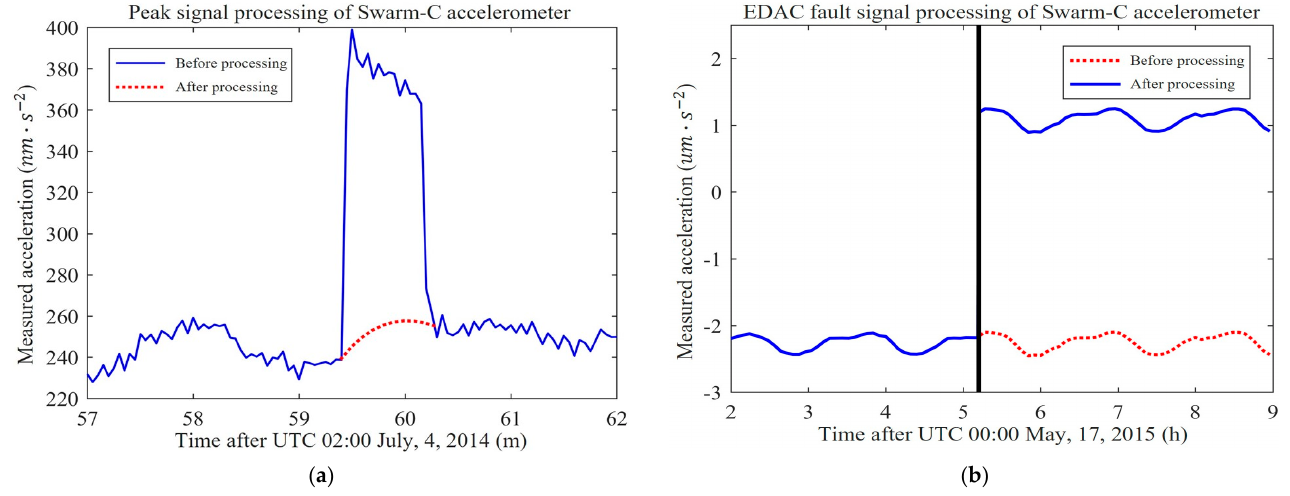
Figure 2. Comparison before and after preprocessing and correcting Swarm-C satellite data. ( a ) Peak signal processing; ( b ) EDAC fault signal processing.